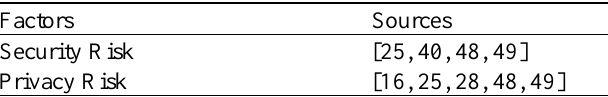
Risk Factors Influencing Trust